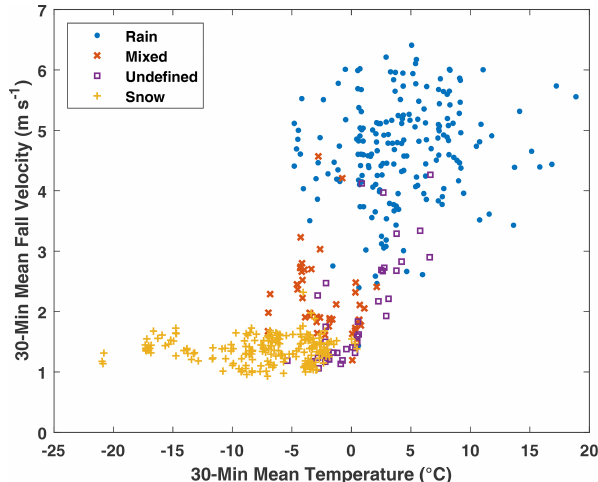
Figure 1. Mean air temperature and fall velocity for 30min events with rain, snow, mixed, and undefined precipitation (see Table 2 for